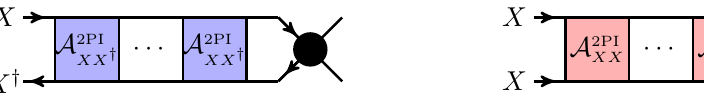
Figure 10 . The long-range interaction a(cid:11)ects the rate of the annihilation processes, and necessi- tates the resummation of the 2PI interactions at in(cid:12)nity. The 2PI kernels are shown in (cid:12)gure 1. The black blob stands for the tree-level annihilation diagrams of (cid:12)gure